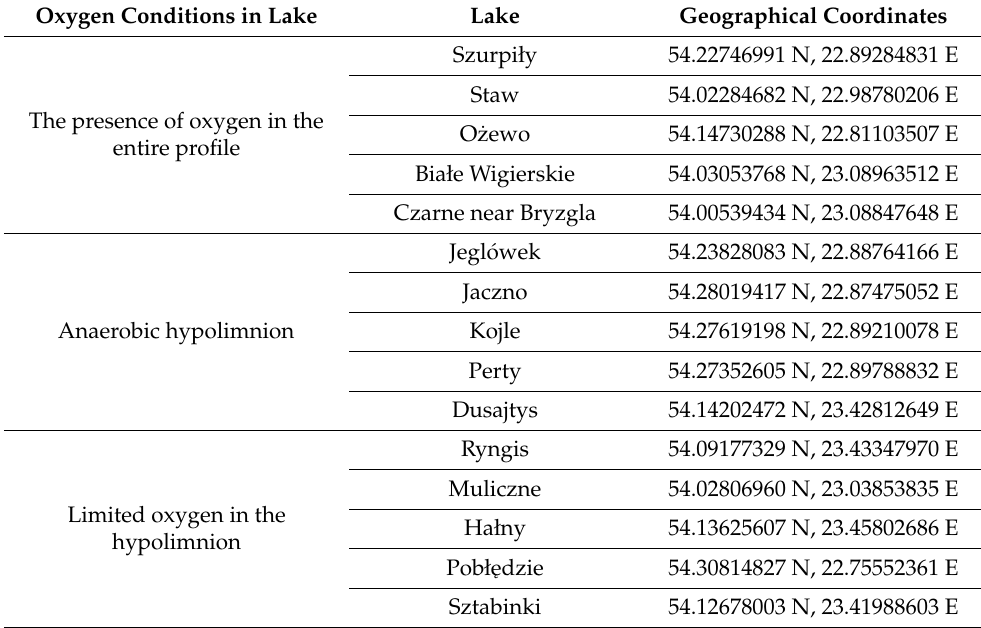
Table 1. Water sampling sites with geographic coordinates. Oxygen Conditions in Lake Lake Geographical